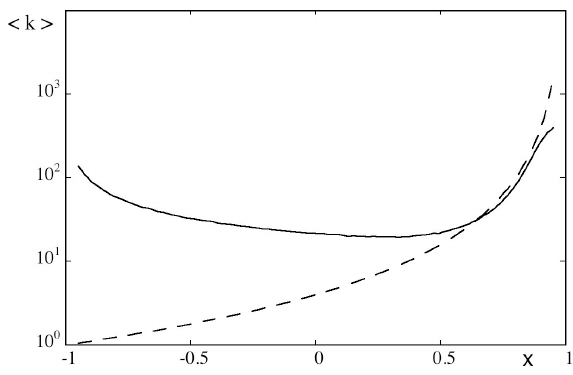
Fig. 5. Mean exceedance time < k > for the deterministic system in Fig. 4a (solid line). The dashed line stands for the prediction of classical EVT theory. From Nicolis and Nicolis (2007).